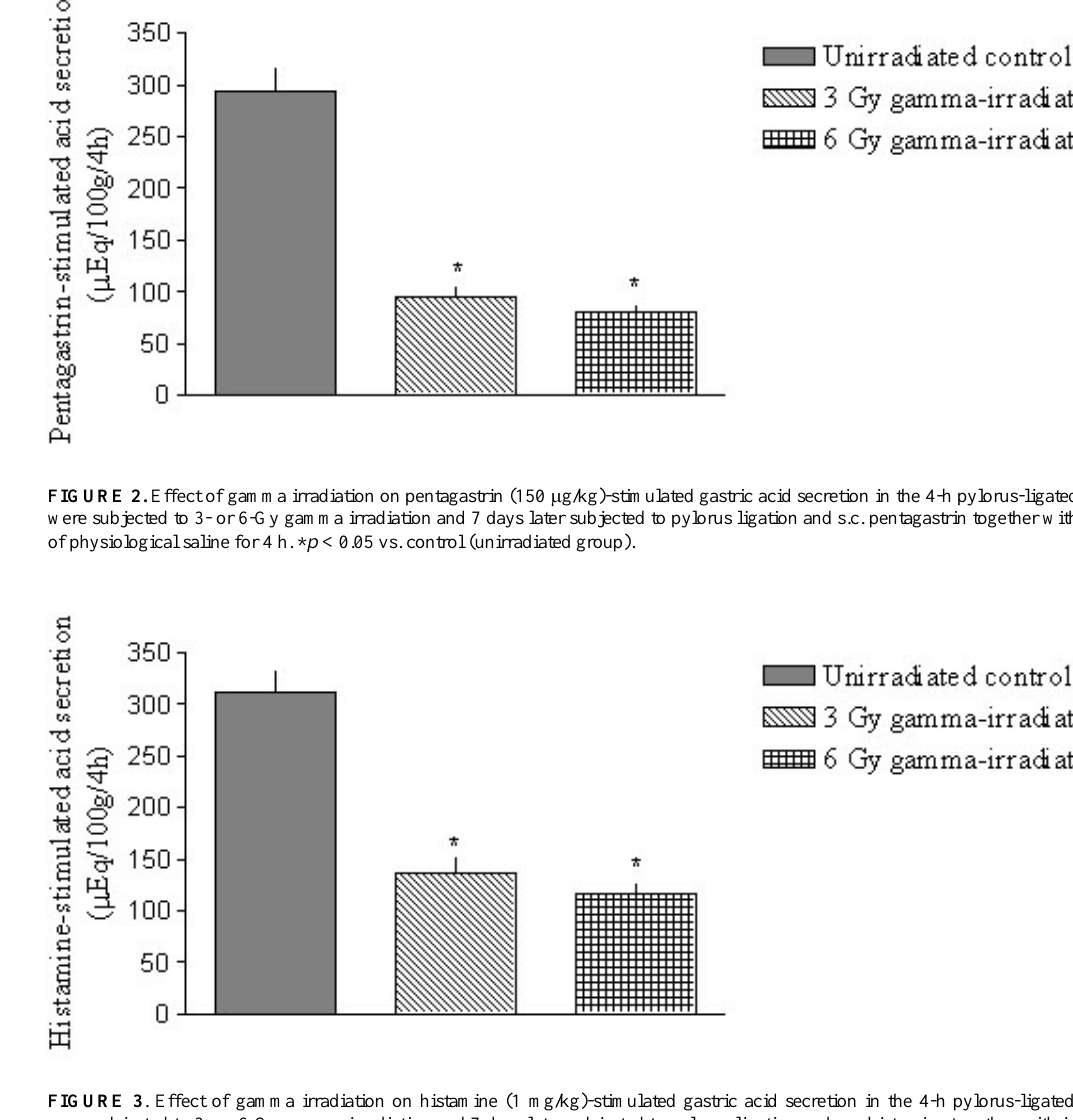
FIGURE 3 . Effect of gamma irradiation on histamine (1 mg/kg)-stimulated gastric acid secretion in the 4-h pylorus-ligated rat. Rats were subjected to 3- or 6-Gy gamma irradiation and 7 days later subjected to pylorus ligation and s.c. histamine together with i.g. 2 ml of physiological saline for 4 h. * p < 0.05 vs. control (unirradiated